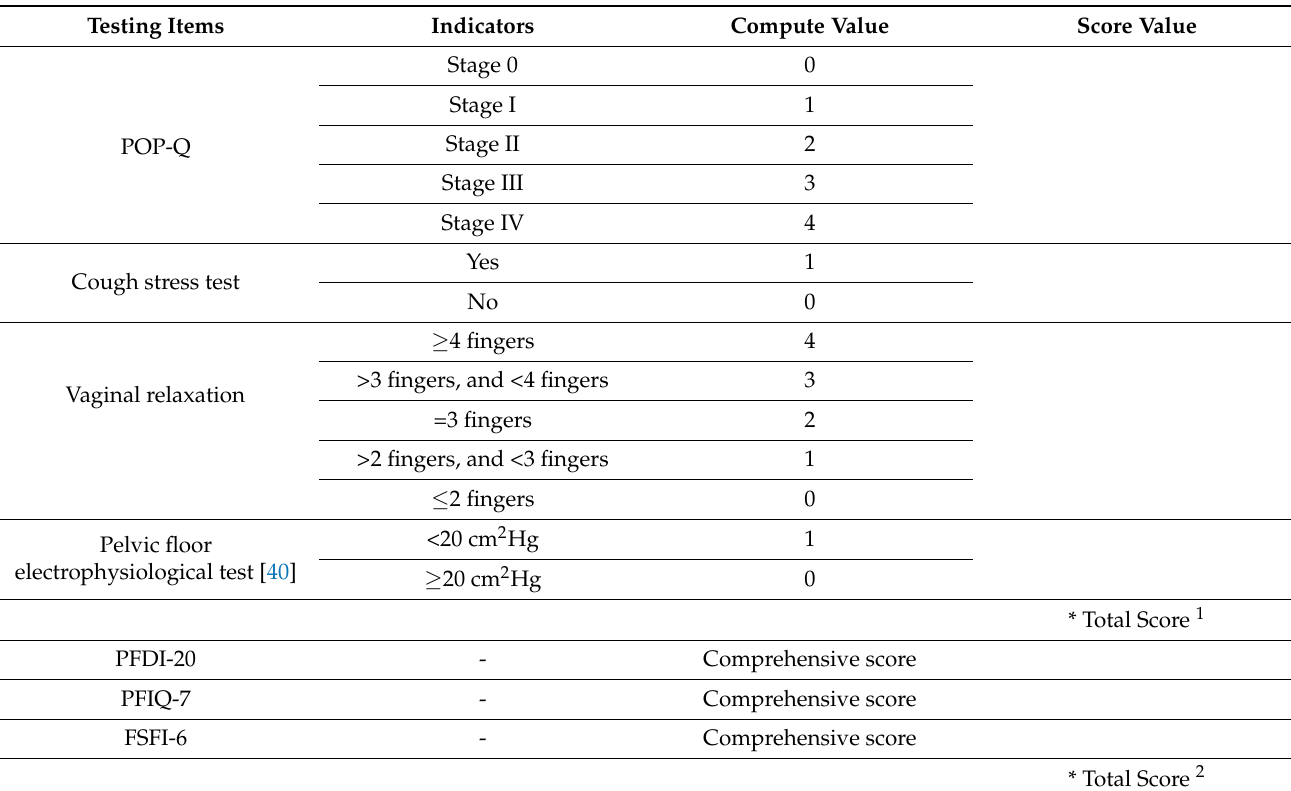
Table 3. Outline of Soring for general pelvic floor